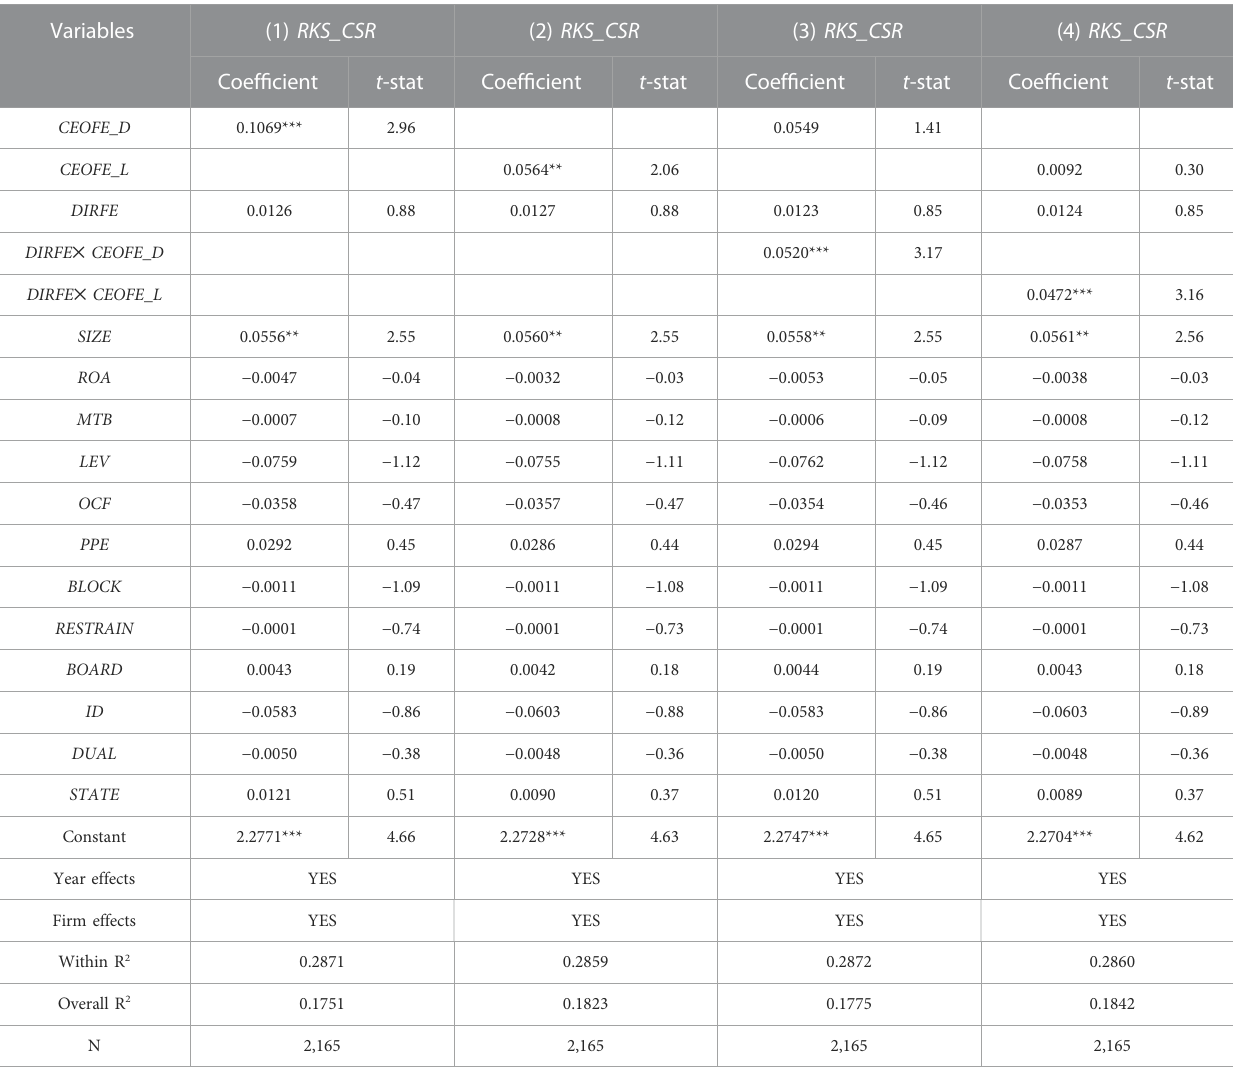
TABLE 8 CEO ’ s foreign experience and CSR (Does directors ’ foreign experience matter).